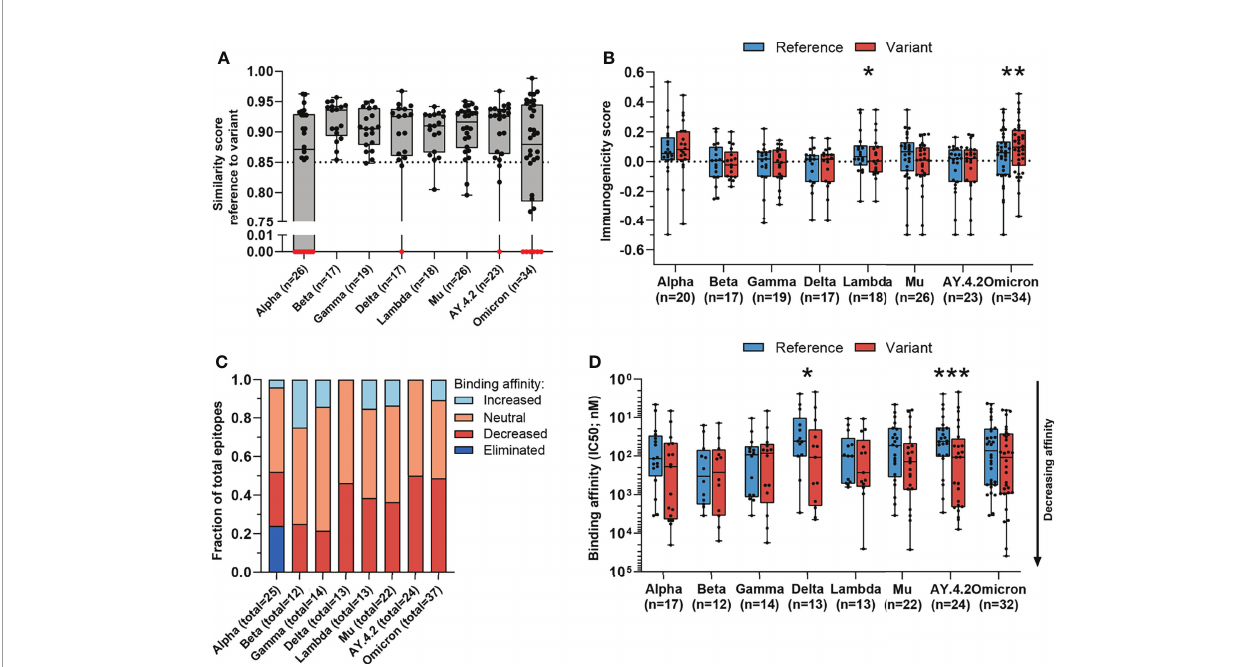
FIGURE 2 | Sequence similarity and predicted binding af fi nity of mutated CD8 T cell recognized epitopes. (A) Sequence similarity scores between the reference SARS-CoV-2 CD8 T cell recognized epitopes and the altered epitopes. Sequence similarity of epitopes in red is set to zero as a result of one or more deletions/ insertions in the epitope sequence (Alpha, n = 3; Delta, n = 2; AY.4.2, n = 2; Omicron, n = 13) or due to the ORF8 Q27* stop codon mutation (Alpha, n = 6). (B) Box plot indicating the predicted immunogenicity of the reference SARS-CoV-2 CD8 T cell recognized epitopes and the altered epitopes according to the IEDB T cell class I pMHC immunogenicity prediction tool. (C) Fractions of total altered CD8 T cell recognized epitopes where the predicted binding af fi nity of the epitope to the corresponding HLA restriction element was increased ( ≤ 0.5-fold change in IC50), remained neutral (0.5< fold change in IC50 <2) or was decreased ( ≥ 2-fold